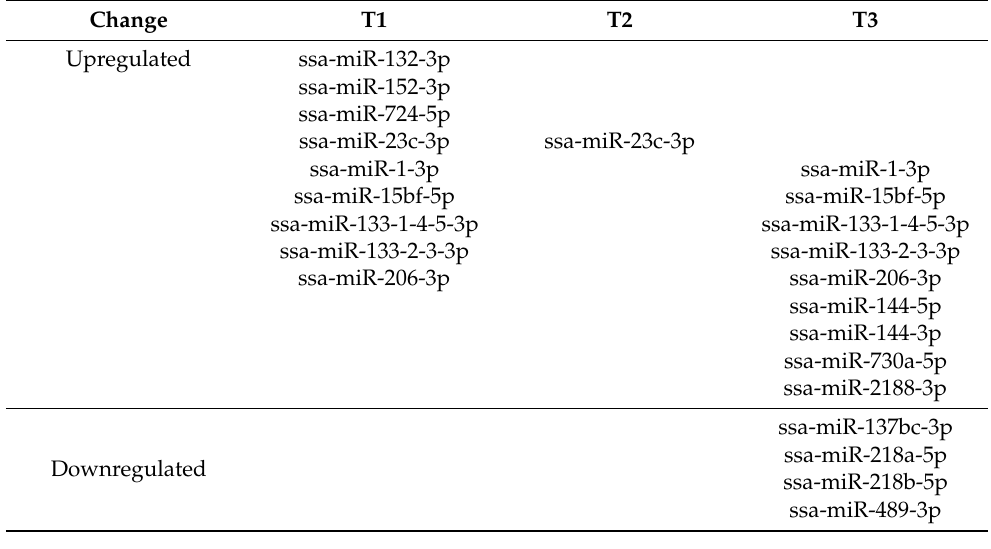
Table 4. Overview of HK gDE-miRNAs and the time points where they showed significant expression changes.